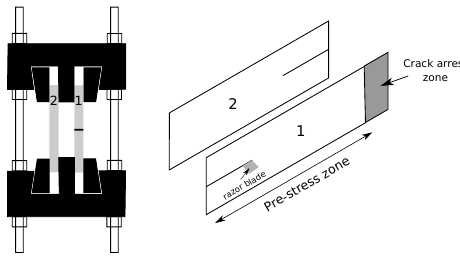
Figure 1. Strip band specimen loading